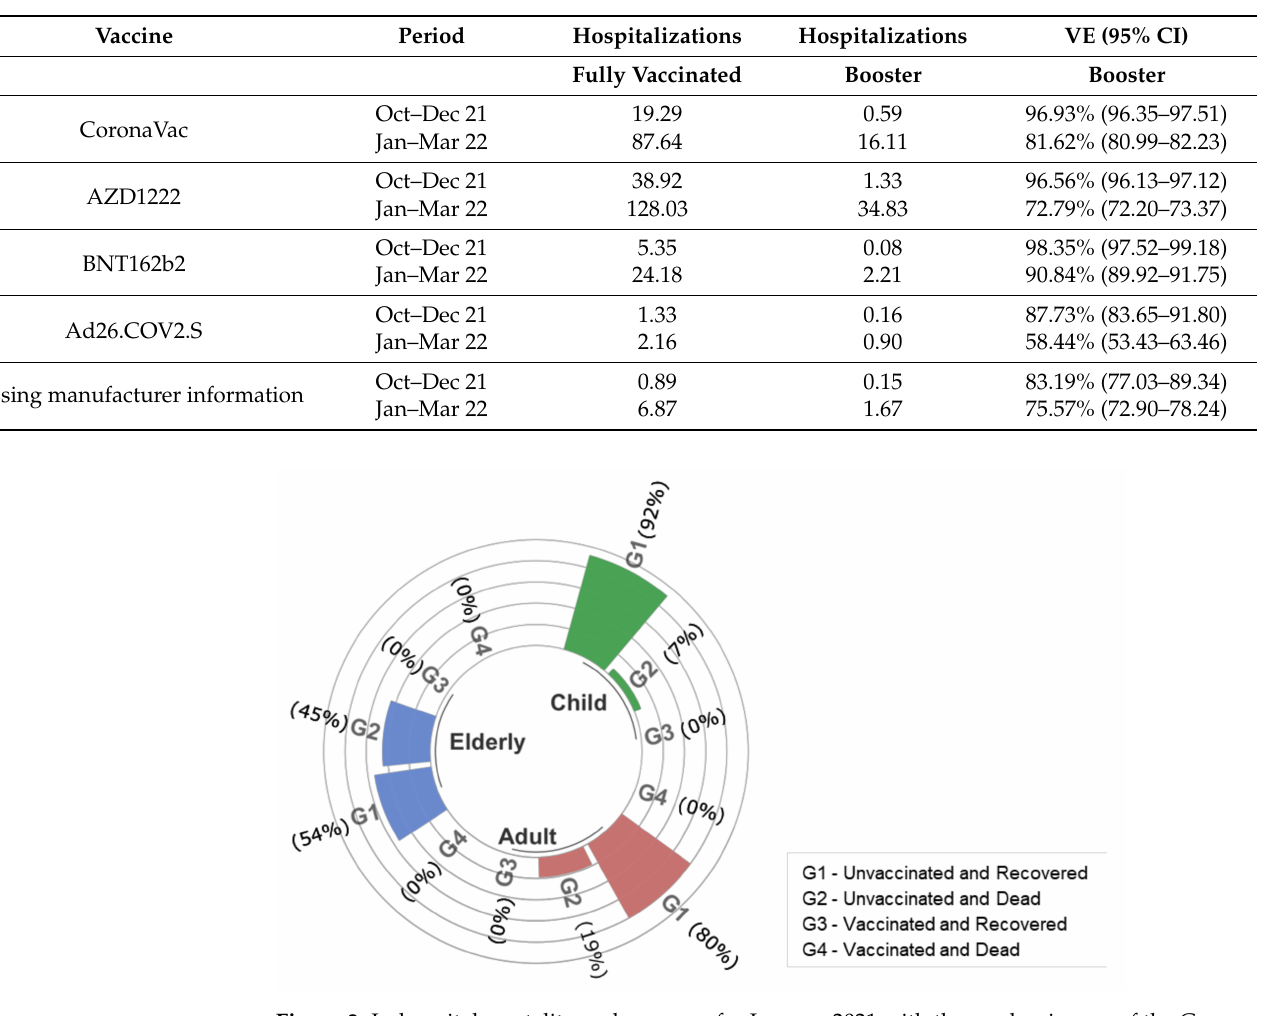
Figure 2. In-hospital mortality and recovery for January 2021 with the predominance of the Gamma variant infections among the hospitalized patients. “G1” stands for unvaccinated and recovered patients, “G2” for unvaccinated and dead, “G3” for vaccinated and recovered, and “G4” for vaccinated and dead. Age was stratified into three groups: child (0–17 years old), adult (18–59 years old), and elderly (over 60 years